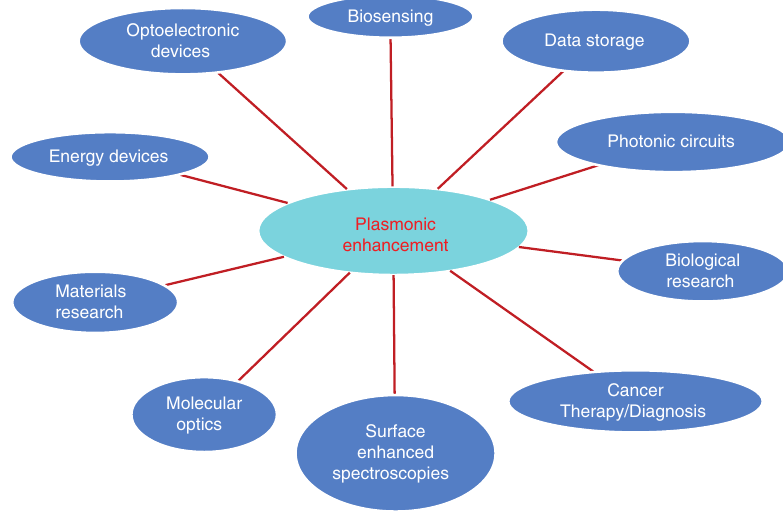
Figure 1: Diagram illustrating the wide applications of local optical field